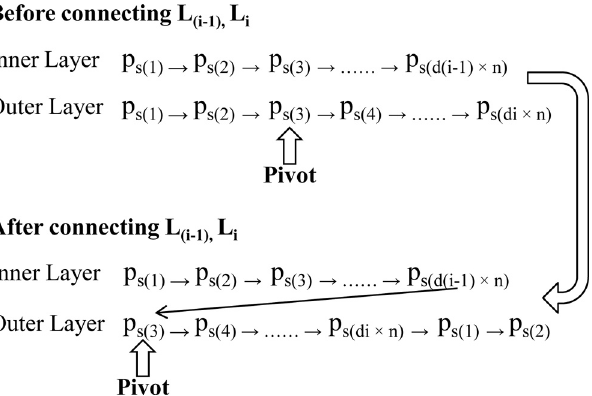
Figure 3. An illustration of connecting partial trails in two adjacent layers, L ð i (cid:7) 1 Þ and l i . P s ð 3 Þ in the outer layer ( l i ) is chosen as the pivot point for connecting the two trails; the last point in the inner layer ( L ð i (cid:7) 1 Þ ) is connected to P s ð 3